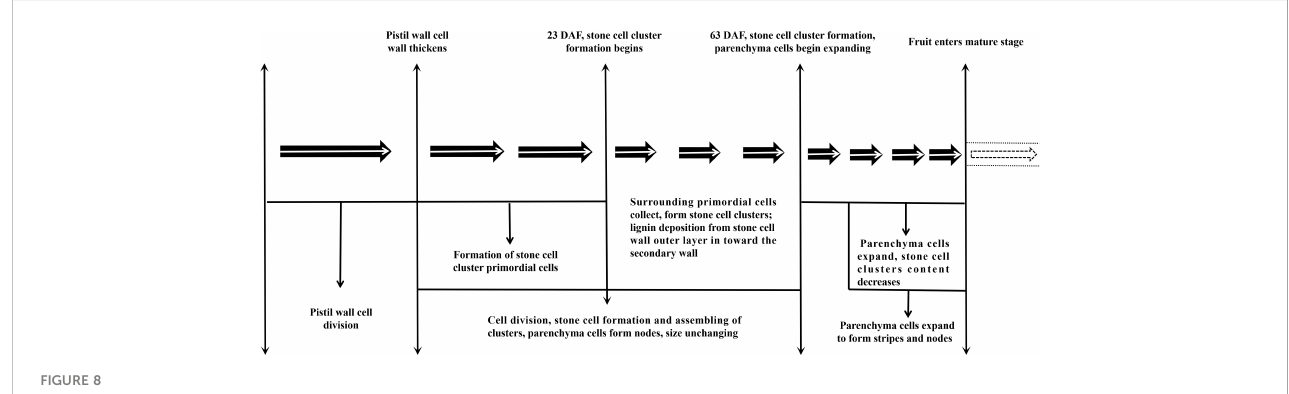
FIGURE 8 Stone cell Development in